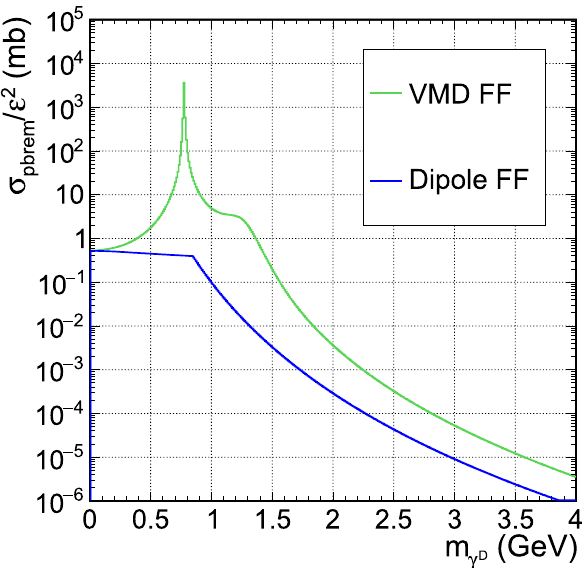
Fig. 4 Proton bremsstrahlung production cross section as a function of m γ